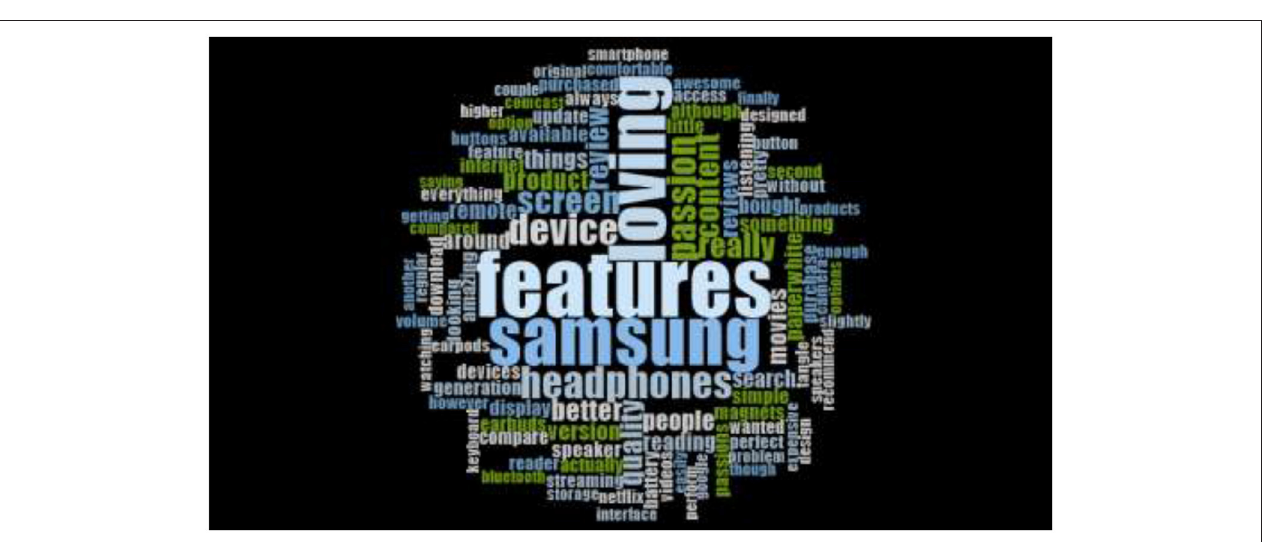
Nvivo 12 has generated word cloud, which is the graphical representation of words. The word cloud of current study generated with the words was having similar meaning. Word cloud has been recognized with another name tag cloud is actually visual representation of the unstructured text